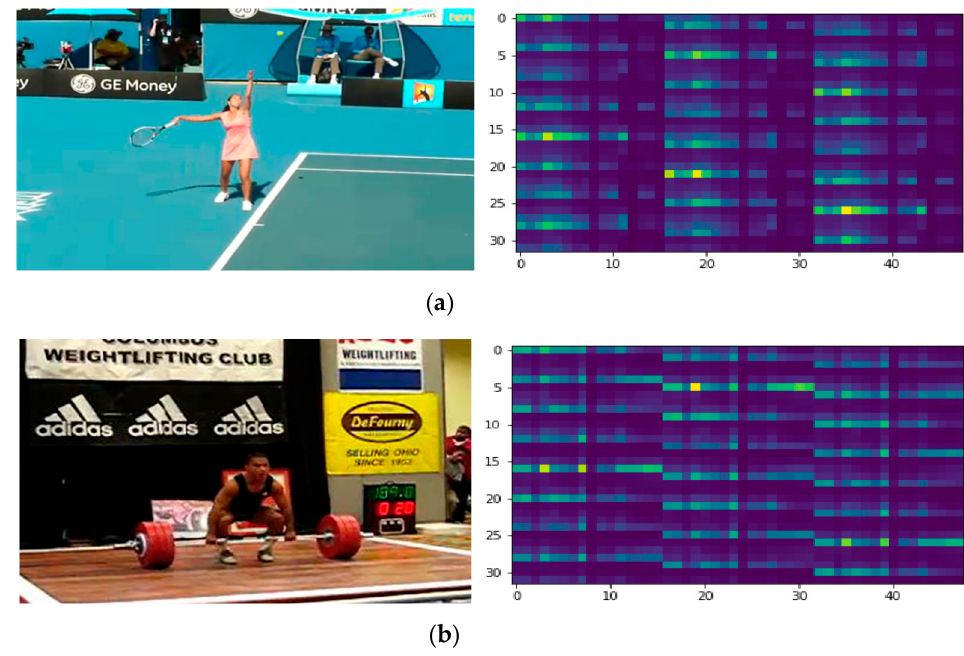
Figure 10. GIST descriptor. ( a ) An outdoor (tennis court) scene (left) and its GIST descriptor (right), ( b ) an indoor (gymnasium) scene and its GIST descriptor.